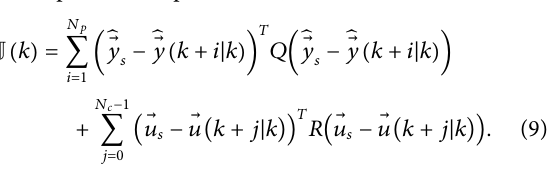
Frontiers in Physiology |